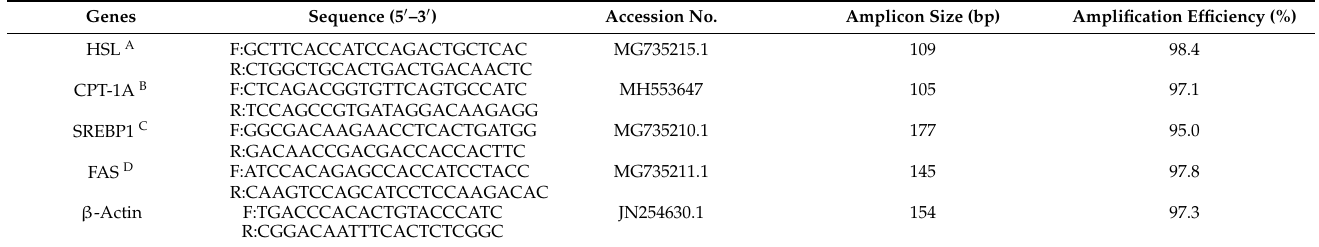
Table 2. Primers used for fluorescence quantification for O. macrolepis exposed to starvation and refeeding